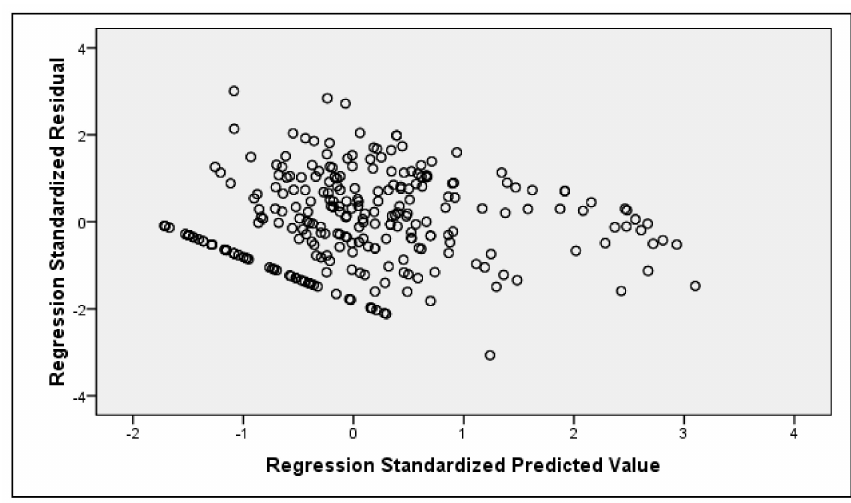
Figure A5. Scatter plot between the regression-standardized residual and the regression-standardized predicted